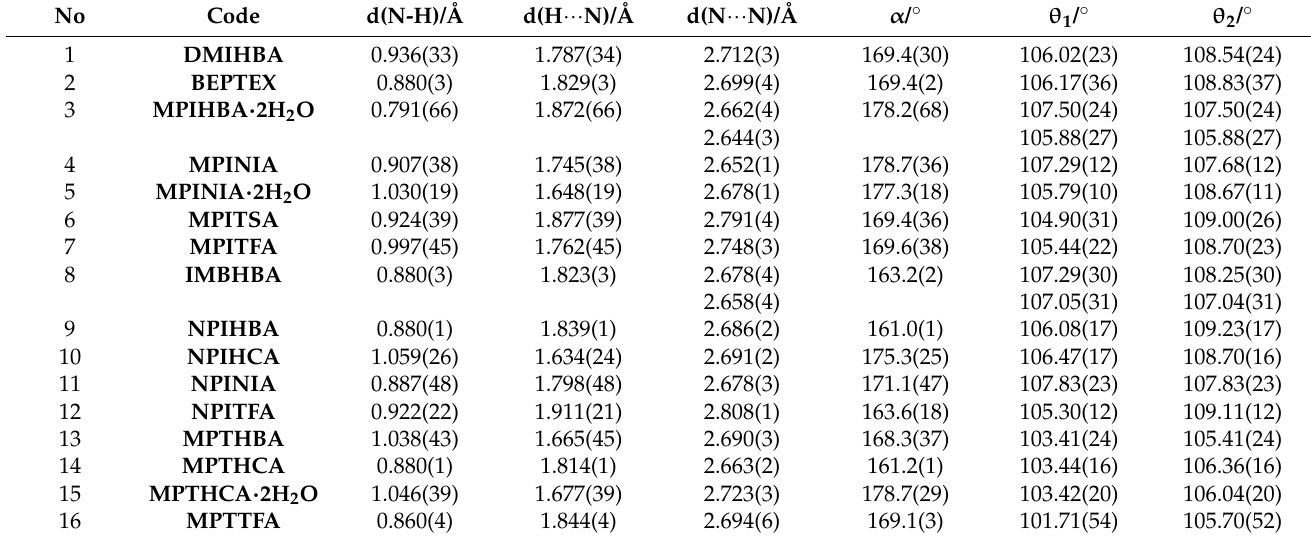
Table 2. Geometries of NH + ··· N hydrogen bonding synthons for